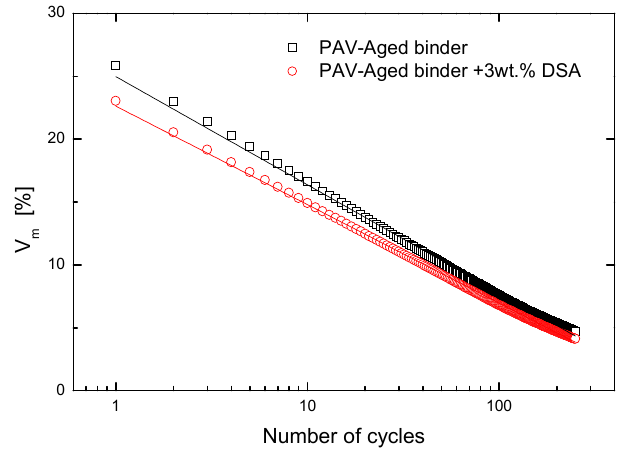
Figure 14. Evolution of air content with number of cycles for a PAV aged bitumen before and after DSA modification.